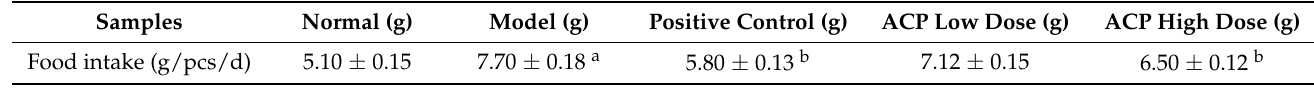
Table 2. Effects of ACP on food intake in